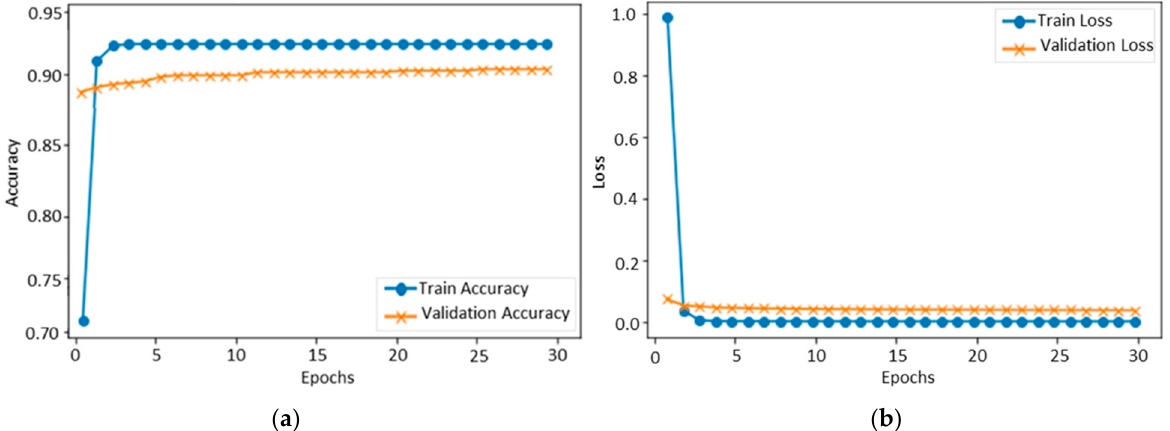
Figure 5. Training and validation of the proposed model over FER-2013: ( a ) accuracy and ( b ) loss.